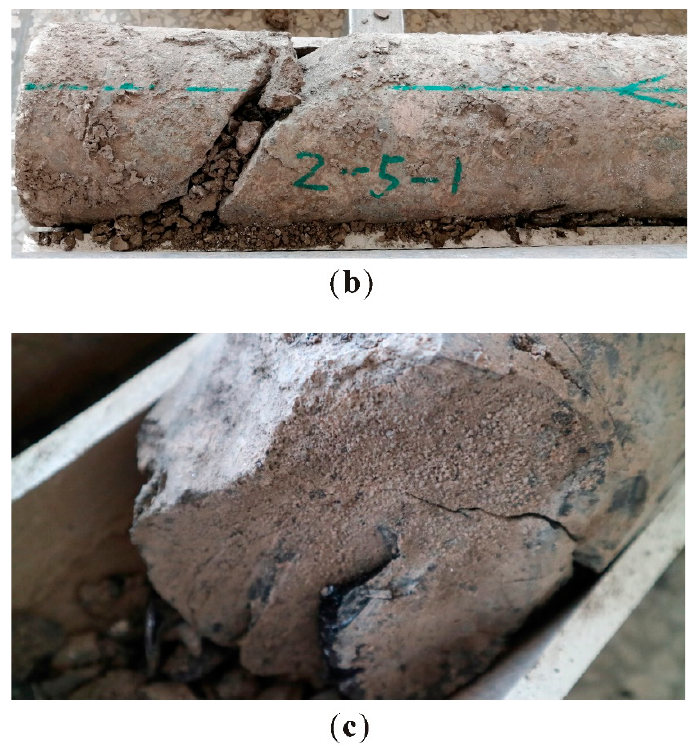
Figure 7. Filling materials in hydraulic fracture. ( a ) A film of dried mud on the surface. ( b ) Thick drilling mud sediment in the fracture. ( c ) Proppant attached to the fracture surface.